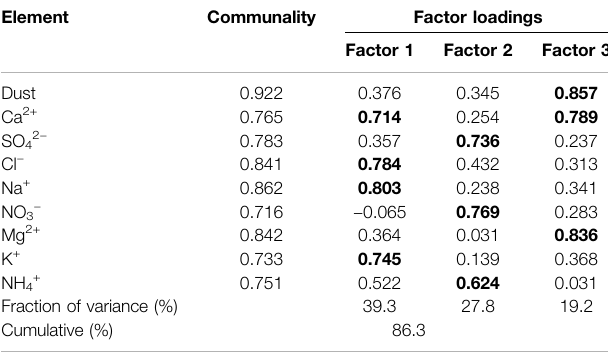
TABLE 2 | Factor loading matrix for ions in snow pits at Yushugou Glacier No. 6. Element Communality